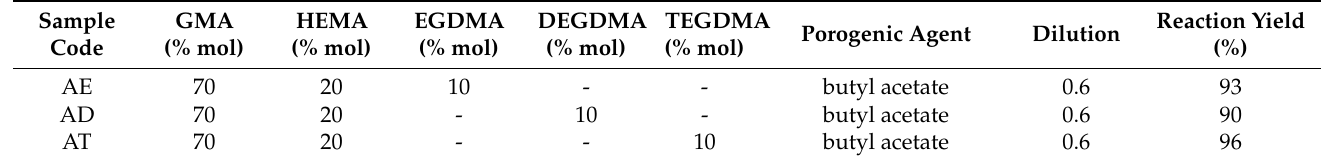
Table 1. The experimental conditions for the synthesis of precursor